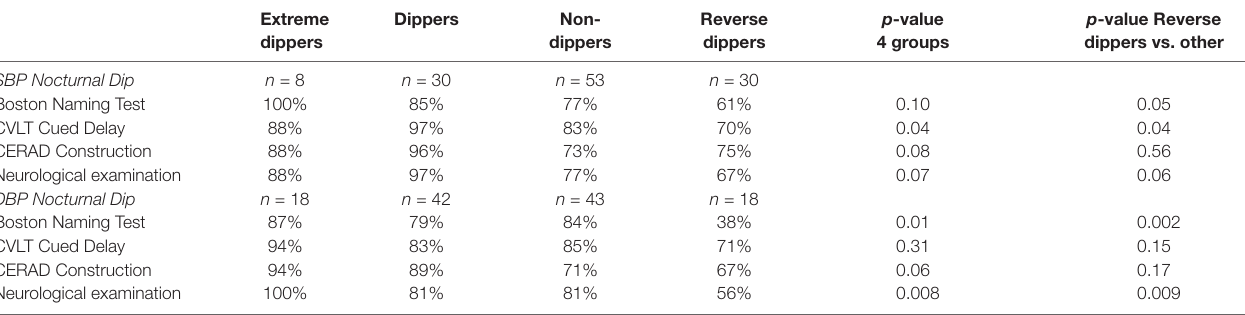
TABLE 6 | Percent normal (above median norm) on cognitive tests and on neurological examination by nocturnal BP dipping category. Extreme dippers